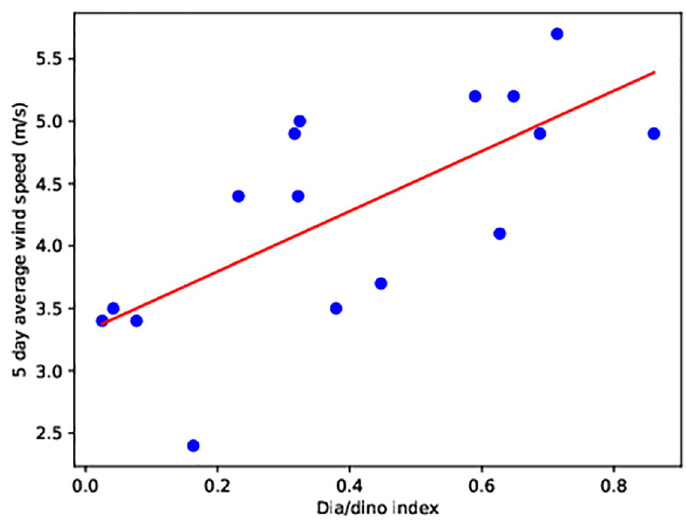
Fig 11. Dia/dino index calculated from the measurements and five-day wind speed average from 1993–2008. Data taken from EPA Lithuanian and ERA 5. Regression line in red.